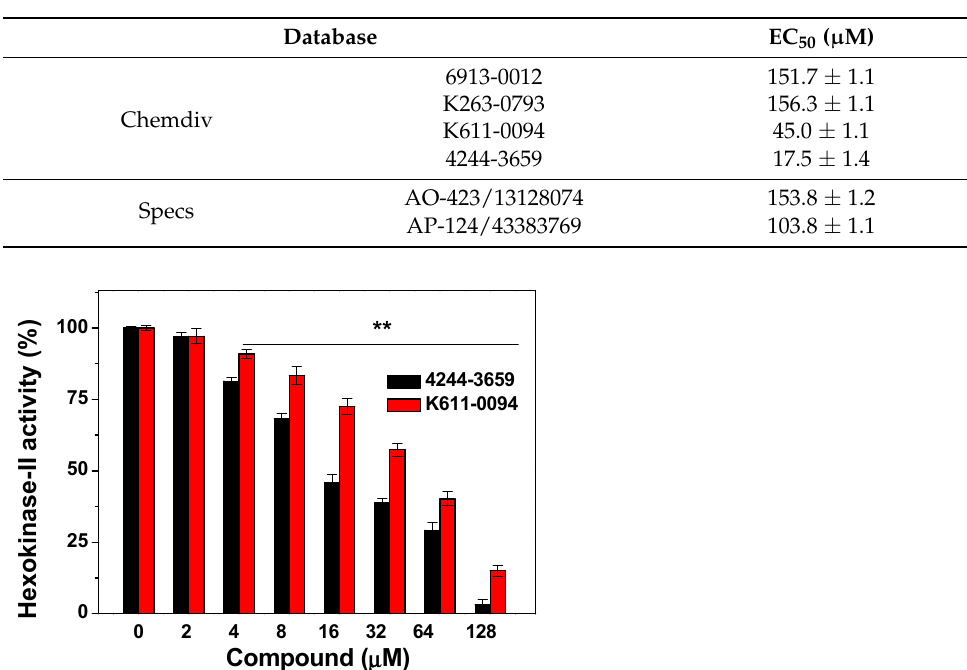
Table 3. Inhibitory effect of compounds on HK-II enzyme activity.